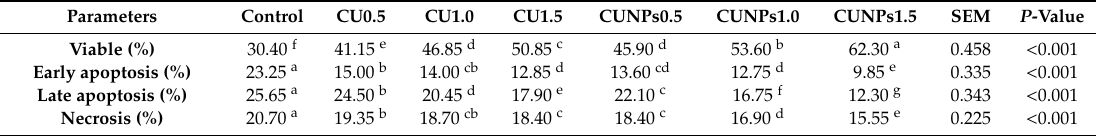
Table 2. E ff ect of di ff erent levels of curcumin (CU) and curcumin nanoparticles (CUNPs) on sperm apoptosis in post-thawed rabbit sperm (mean ±